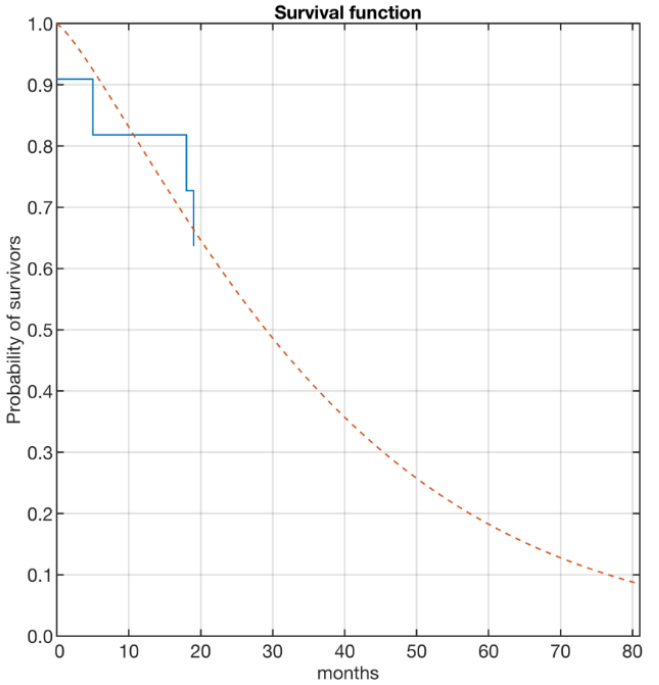
Figure 2. Plot of the survival curve of the treated patient population. Blue line = experimental curve; Orange line = interpolation. Table 4. Summary table of patient survival data. Table 5. Table of interpolation parameters used for survival estimation. The coefficient of determi- nation and the parameters of the Weibull distribution are shown. The last two columns show an ) and second half-life (t 1 / ) of the estimate of the first half-life (t 1 / 2 4